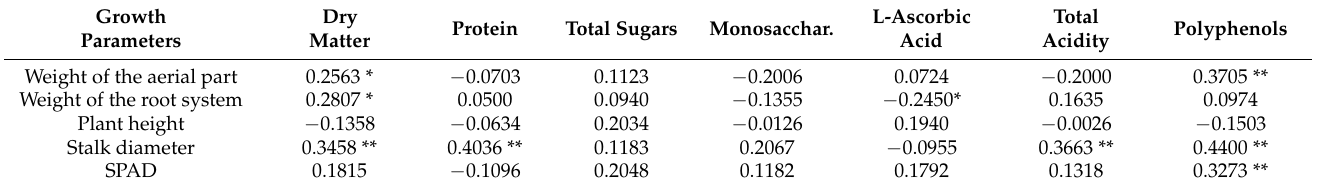
Table 9. Linear correlation coefficients (n = 81) between selected elements of the nutritional value of sweet pepper, and growth parameters of plants and the value of SPAD index. Growth